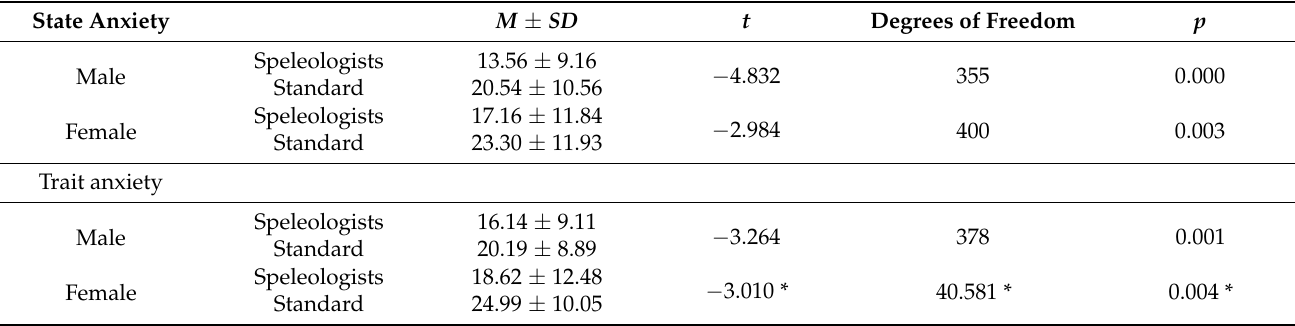
Table 2. State anxiety and trait anxiety values for the sample of speleologists and the standard sample.